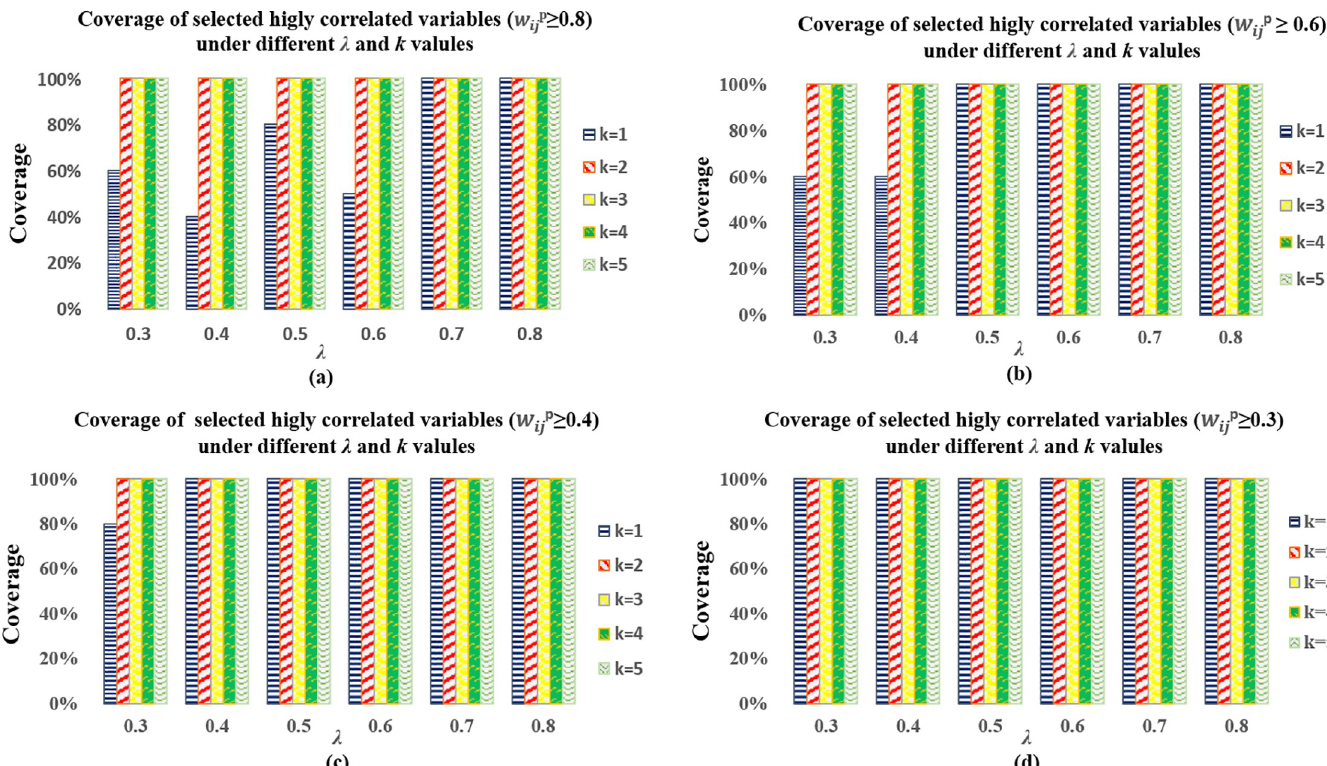
Fig 2. The capability of k -dominating set in selecting proxy variables among highly correlated variables. Ten synthetic undirected networks with n = 1,000 vertices ( V ) were simulated. (a) highly correlated variables defined as w P > 0 : 4 ; (d) highly correlated variables defined as w P w P ij